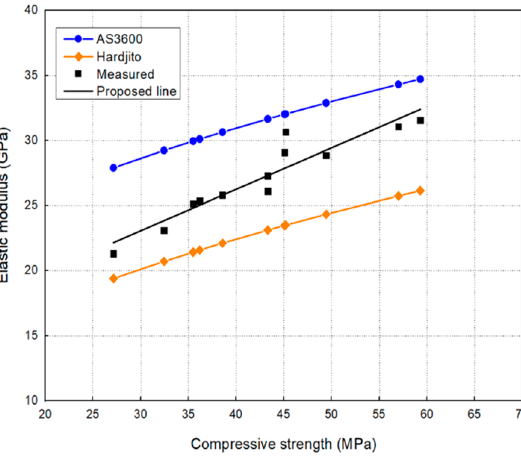
Figure 14. Compressive strength and elastic modulus relationship.